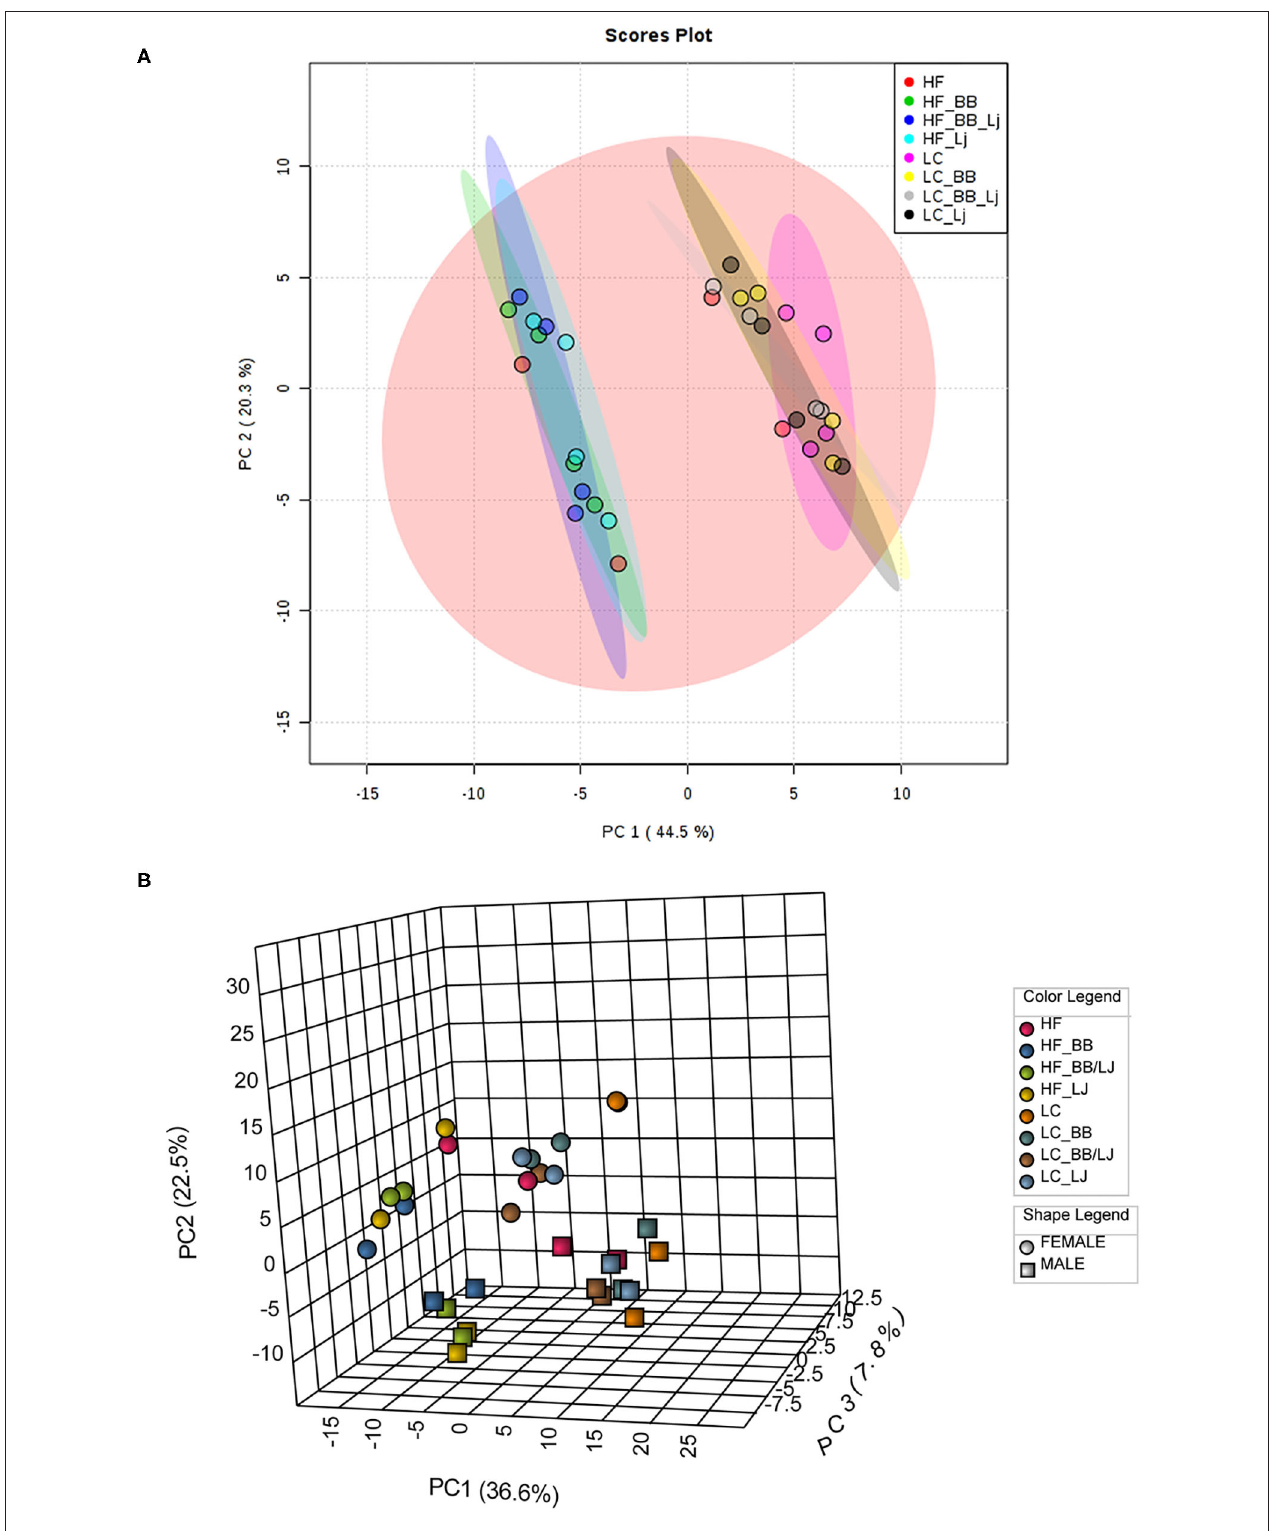
FIGURE 4 | Diet affects overall lipid profile. (A) PCA plot; (B) 3D PCA plot based on sex and diet of all lipids analyzed. PC1 (44.5%) is the diet, which separates the HF from the LC diet. PC2 (20.3%) is the sex, which separates females (spheres) from the males (boxes). PC3 (19.2%) is the treatment, which separates the treatments with blueberry, L. johnsonii N6.2, and the combination of both. HF, high-fat diet; LC, low-calorie diet; BB, blueberry extract; LJ, L. johnsonii N6.2; BB/LJ, blueberry extract + L. johnsonii N6.2.